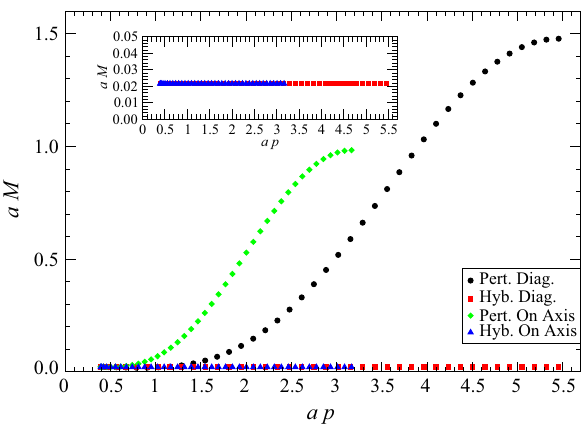
Fig. 9 Tree level propagator mass for three momenta p being along the diagonal of the axis of the lattice. The data reported was computed for T = 305 MeV in a 80 3 × 8 lattice, κ = 0 . 1348 that corresponds to m bare = 53 MeV, and for the first Matsubara frequency. The data referred as “Pert.” is the naïve tree level pole mass appearing in the rotated quark propagator. The data labelled as “Hyb.” is the tree level corrected result for the so-called hybrid definition of the mass.